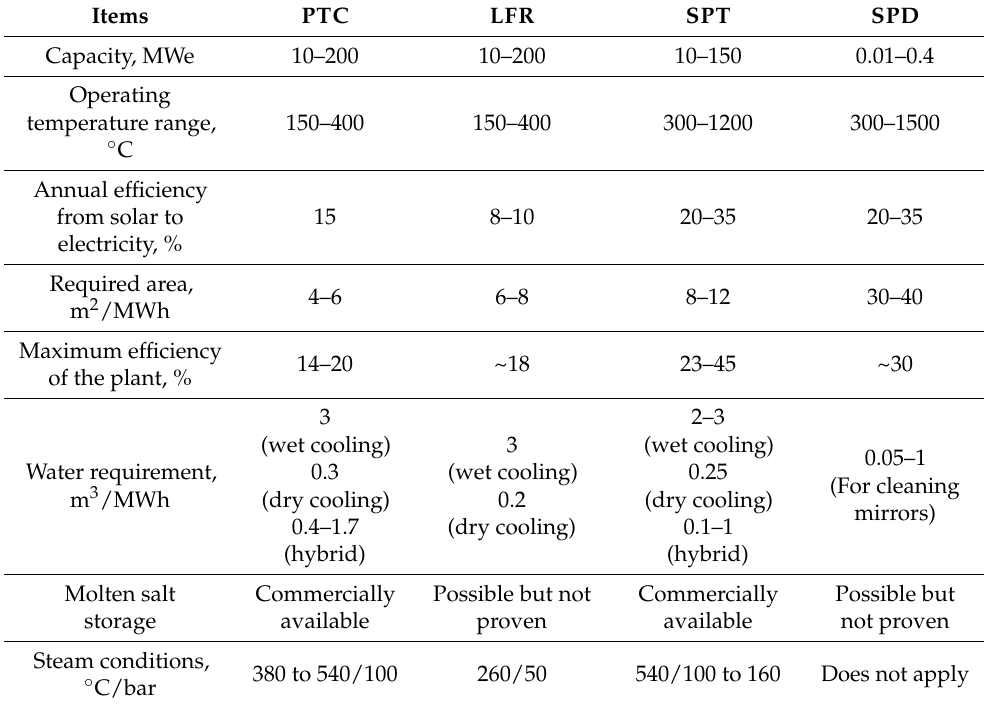
Table 2. Comparative table of technical parameters of CSP technologies